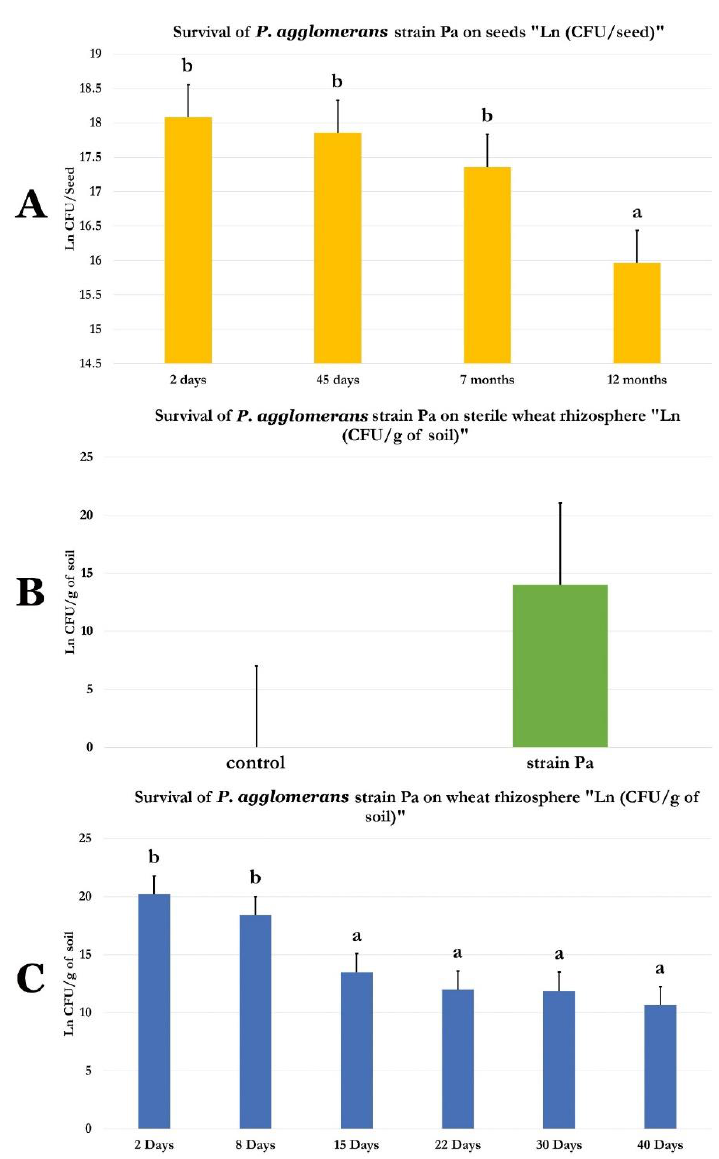
Figure 8. Survival of P. agglomerans strain Pa on ( A ) seeds, ( B ) sterile wheat rhizosphere, and ( C ) non-sterile wheat rhizosphere.